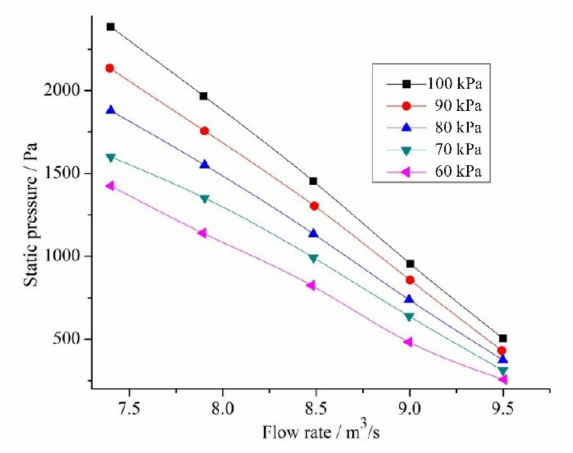
Figure 8. Static pressure of the fan under di ff erent ambient